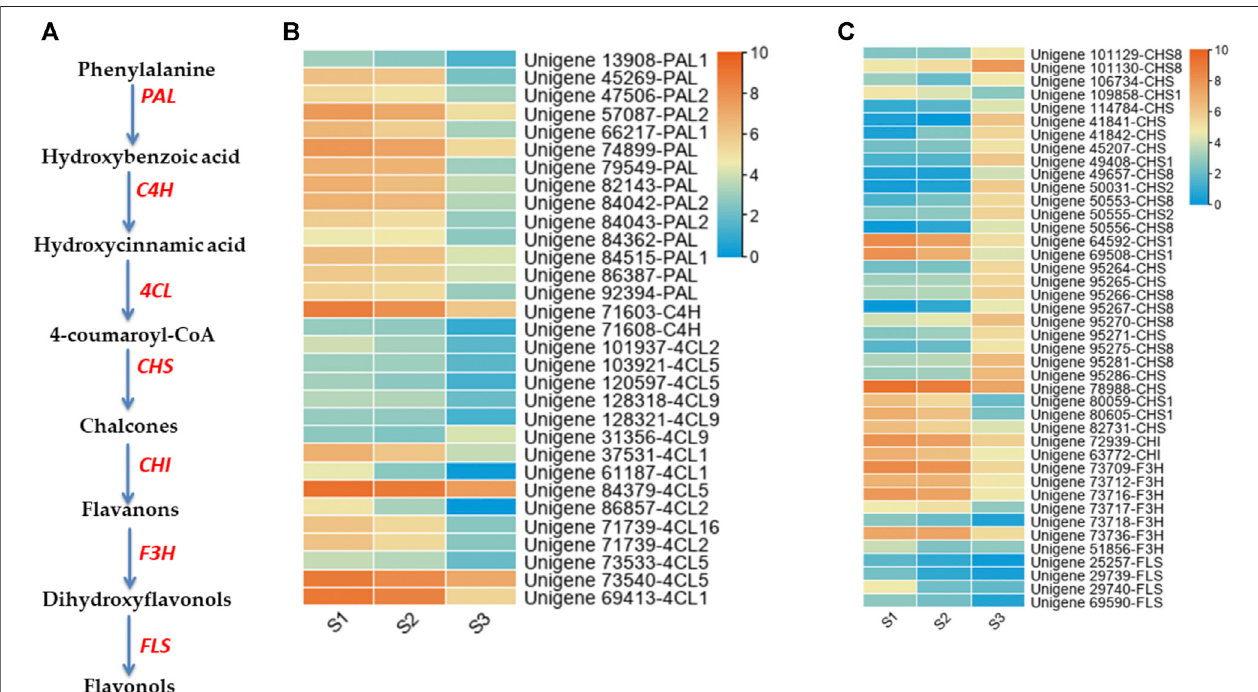
FIGURE 7 | Expression pro fi les of phenolic acid and fl avonoid pathway genes distribution at three developmental stages of M. ternifolia nutshell (A) Simplest diagram of phenolic acid and fl avonoid biosynthesis pathway (B) Phenolic acid metabolism related DEGs (C) Flavonoids pathway related DEGs.